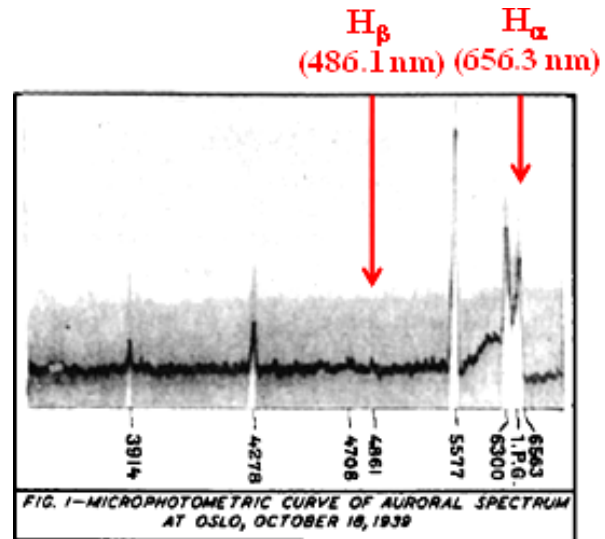
Figure 1. Vegard’s first spectrum illustrating the presence of hydro- gen emissions from an aurora, recorded at the University of Oslo on 18 October